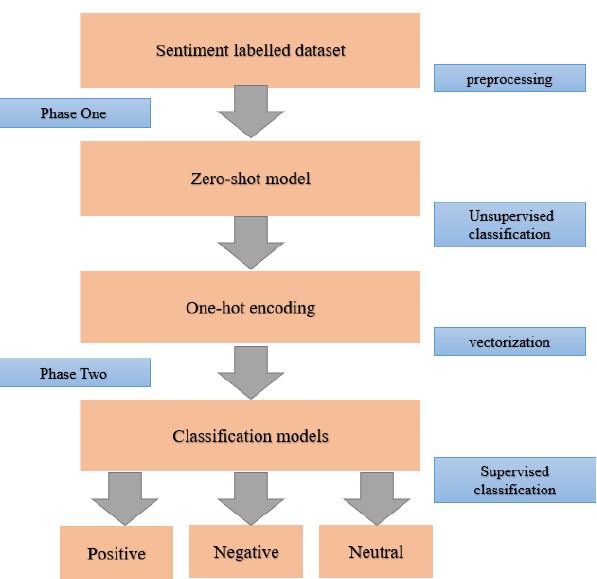
Table 3. Set of emotions used for zero-shot classification.